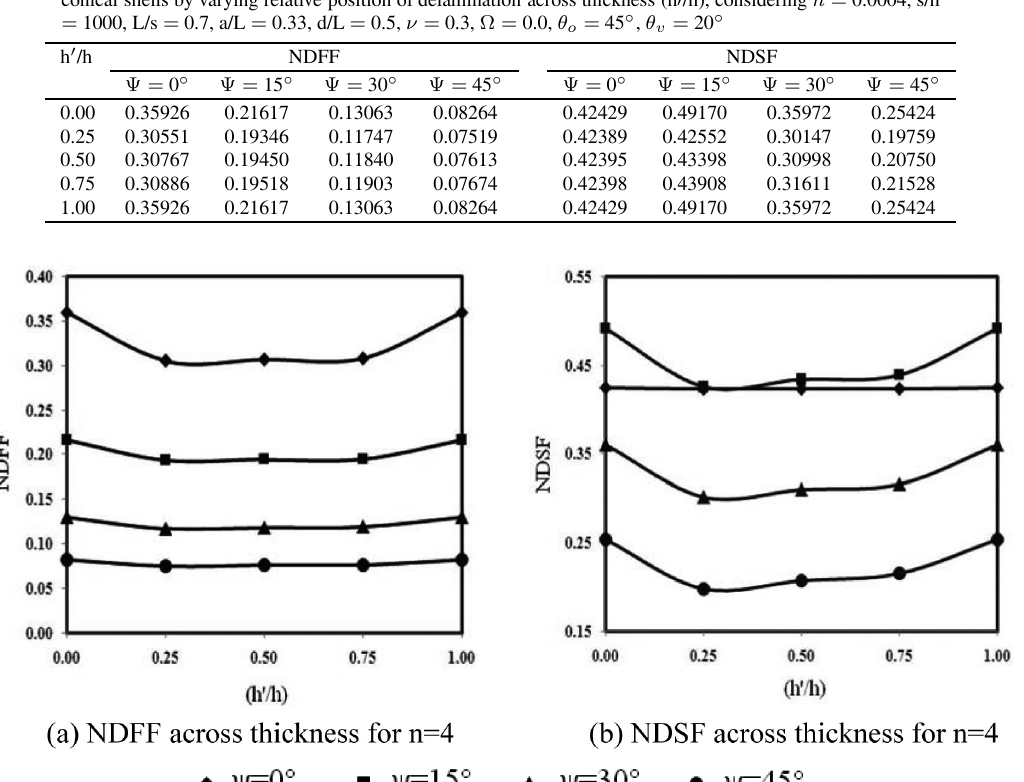
Table 4 NDFF and NDSF of four layered [0 ◦ /90 ◦ /0 ◦ /90 ◦ ] graphite-epoxy cross-ply composite pretwisted shallow